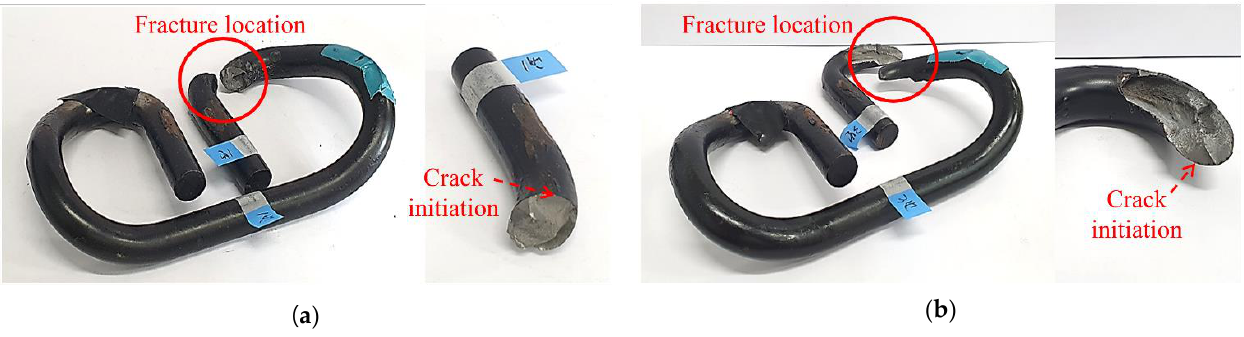
Figure 13. Fatigue failure modes: ( a ) mode 1; ( b ) mode 2.